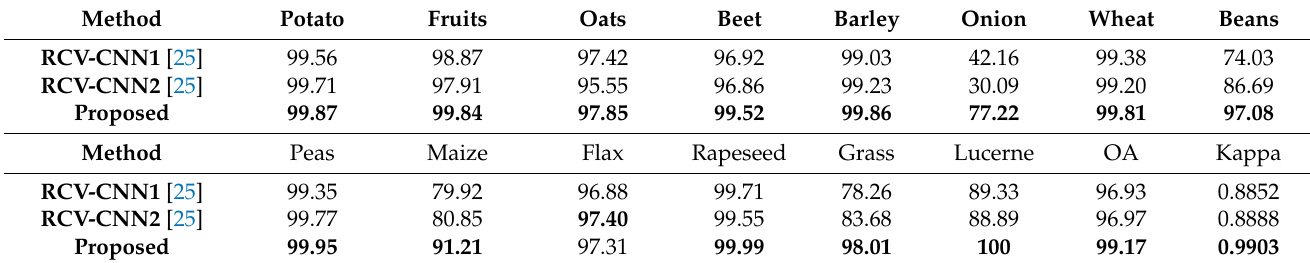
Table 4. Accuracy and Kappa coefficients of dataset 2 for three semi-supervised methods under the condition of 1% sample ratio.